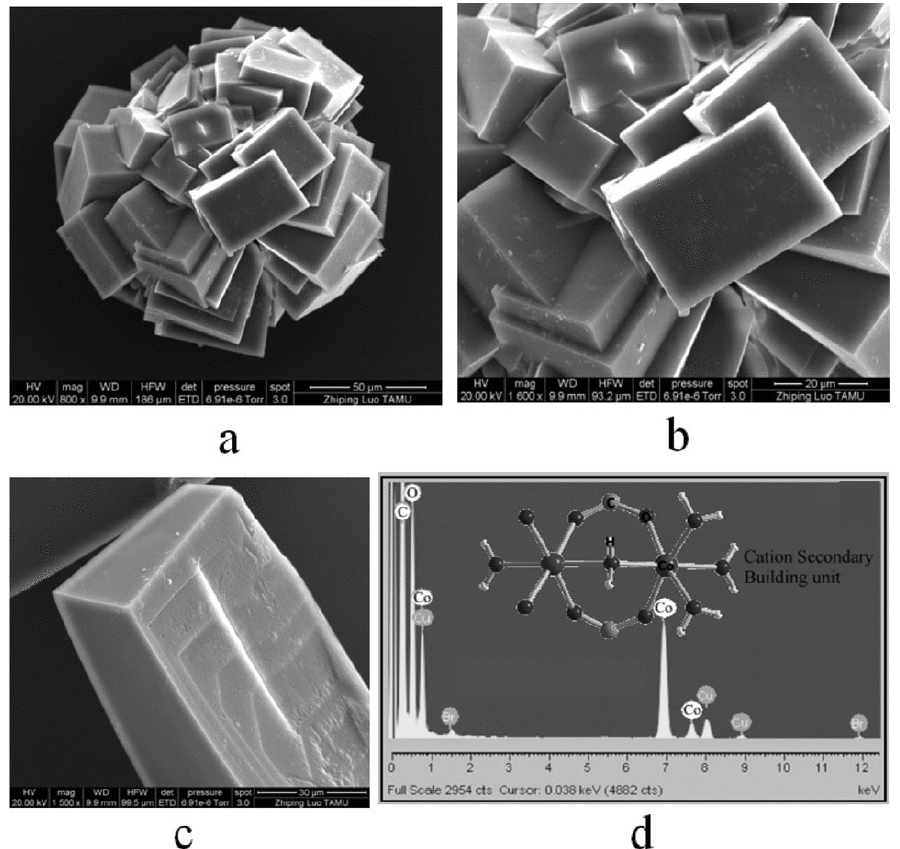
Figure 13. ( a – c ) SEM images of Co-TDM crystals; Scale bars: 50 µ m, 20 µ m, and 30 µ m, respectively ( d ) EDS elemental analysis of Co-TDM with cation secondary building unit shown at the background. Reproduced with permission from [96].